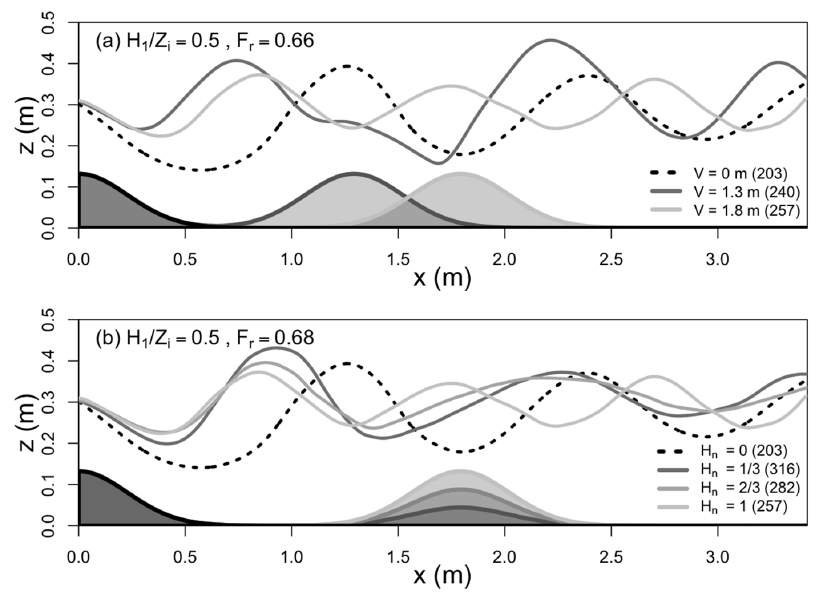
Figure 9. Same as in Figure 7, except for H 1 /Z i = 0.5 and F r = 0.66–0.68.